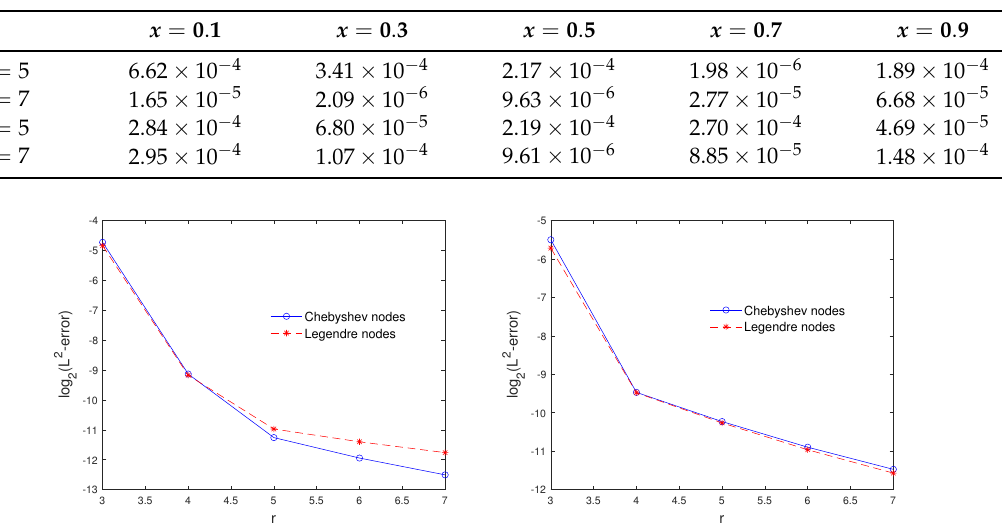
Figure 1. The L 2 –errors for µ = 1 ( right ) and µ = 5/6 ( left ) at the Chebyshev and Legendre nodes for Example